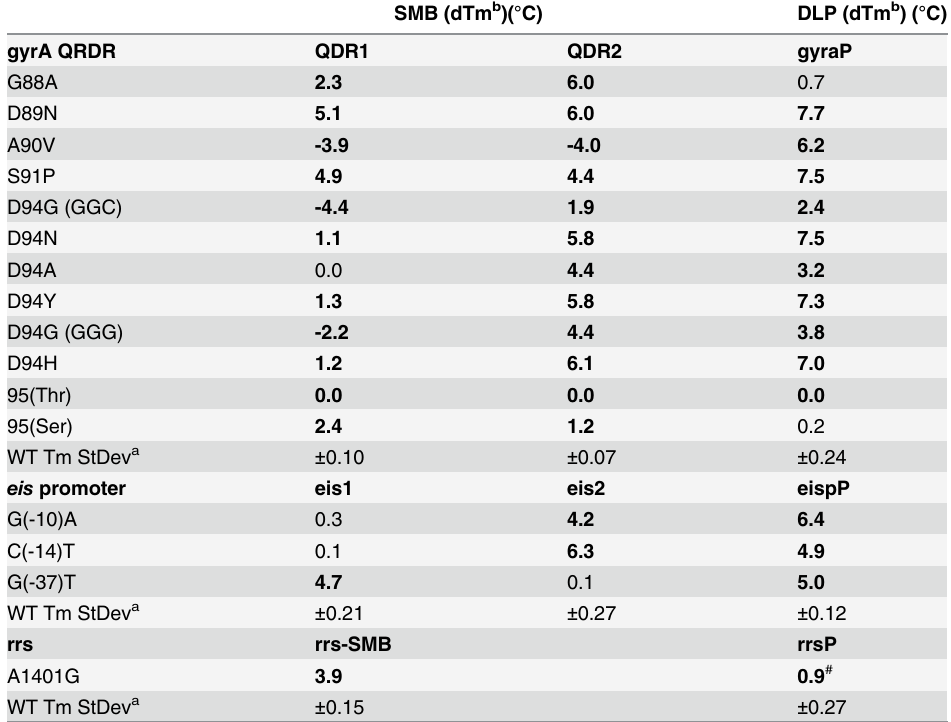
Table 2. Average dTm values for mutations tested by both DLP and SMB gyrA , eis promoter and rrs